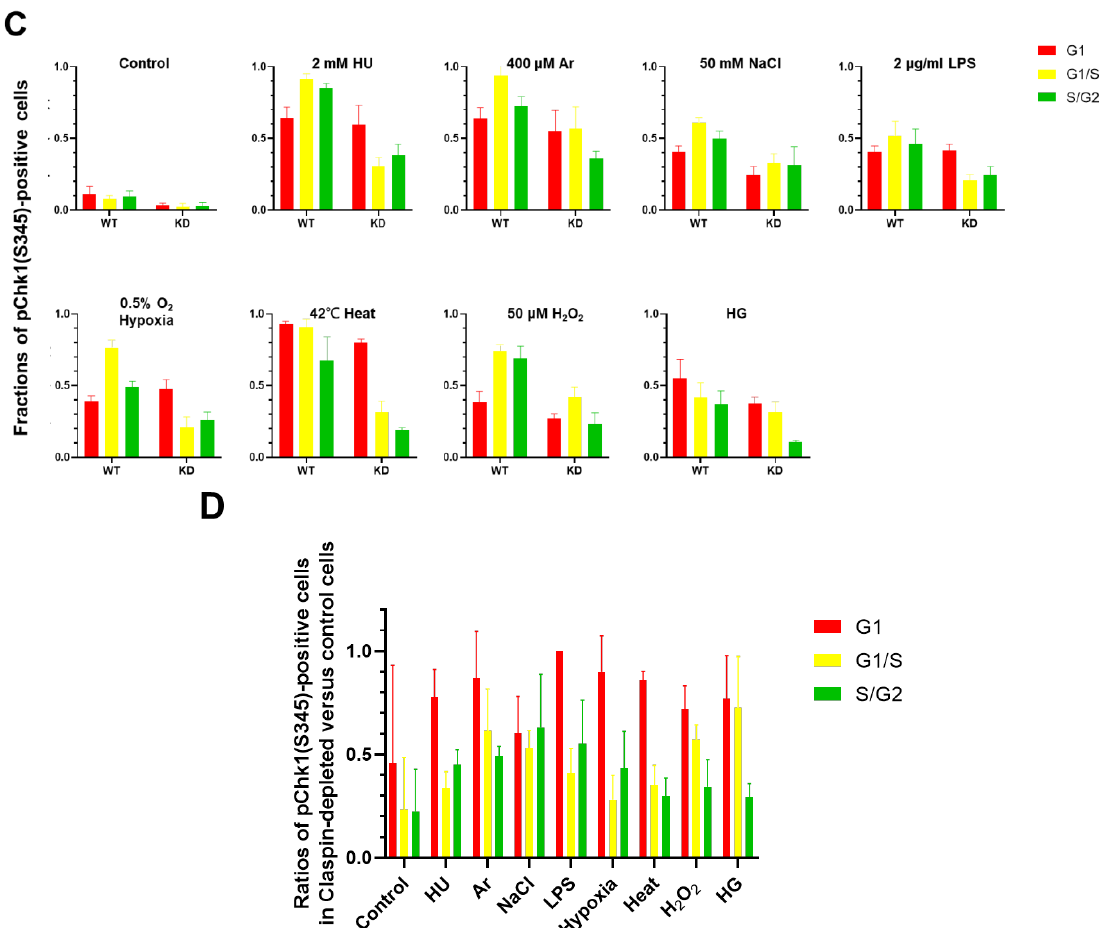
Figure 6. Claspin depletion abrogates Chk1 activation induced by various stresses mainly during the S phase. ( A ) and ( B ) U2OS Fucci cells were transfected with Claspin siRNA or with control siRNA for 48 h and were exposed to various stresses for 3 h before the cell harvest. The whole cell extracts from a portion of the cells were analyzed by Western blotting to detect Claspin and tubulin. ( B ) The same cells were observed under confocal microscopy (Zeiss LSM710). Blue, Hoechst (DNA); green, mAG-Geminin (S/G2 cells); red, mKO2-Cdt1 (G1 cells); white, pChk1(S345) (replication checkpoint). ( C ) Fractions of pChk1(S345)-positive cells in the U2OS Fucci cells of a specific cell-cycle stage after exposure to various biological stresses. ( D ) Ratios of pChk1(S345)-positive cells in Claspin-depleted versus control cells in cells of the specific cell-cycle stage. The higher values indicate the less dependency of the pChk1 signal on the Claspin function. All statistical analyses represent the indicated mean values ± SEM under two independent experiments, all of which included three replicates; + and—refer to the cells transfected with Claspin siRNA and those transfected with control siRNA, respectively.